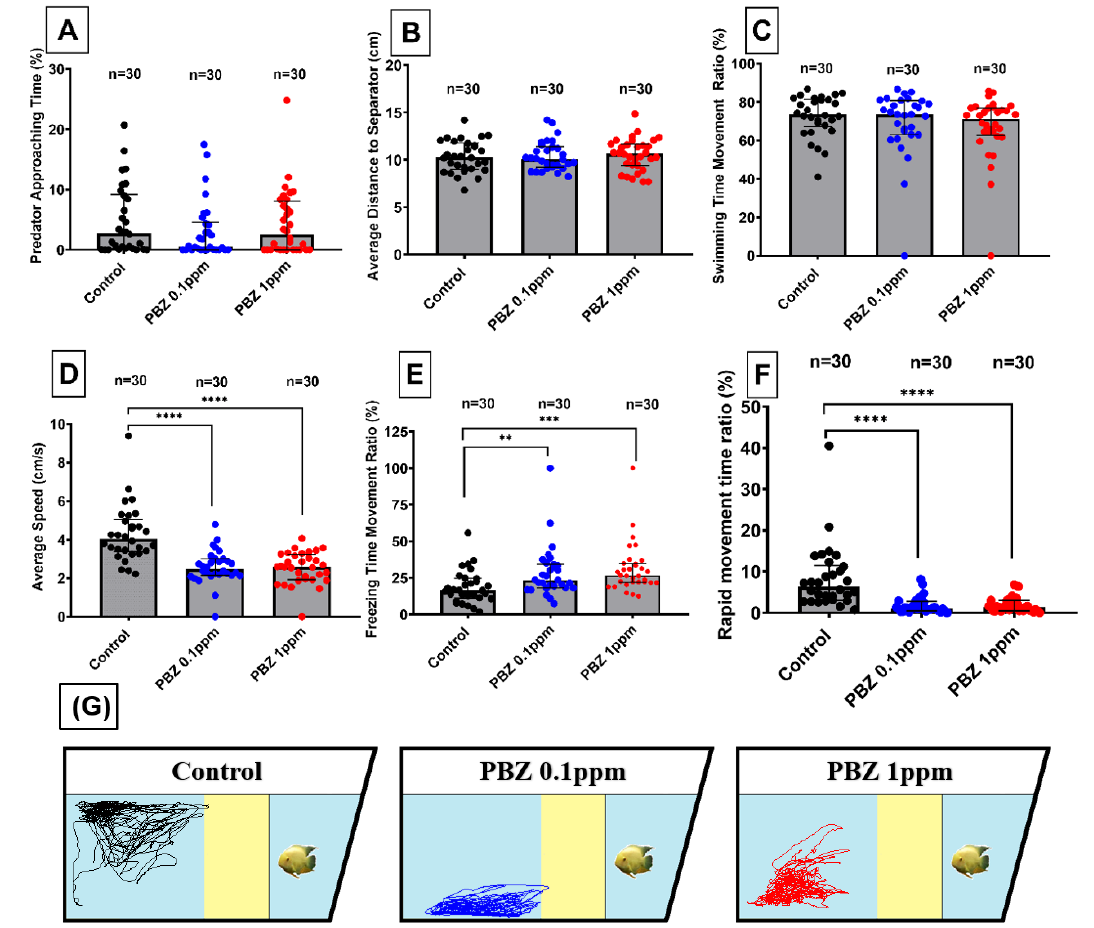
Figure 7. Predator avoidance test for adult zebrafish after exposed to different doses of Paclobutrazol. Six endpoints were measured including: ( A ) predator approaching time, ( B ) average distance to the separator, ( C ) swimming time movement, ( D ) average speed, ( E ) freezing time movement, and ( F ) rapid movement time ratio. ( G ) Trajectories of adult zebrafish in predator avoidance assay after exposed to 0 (control), 100 µg/L (0.1 ppm), and 1000 µg/L (1 ppm) of Paclobutrazol (PBZ). The data are expressed as the means ± S.E.M. and were analyzed by the one-way ANOVA (** p < 0.01, *** p < 0.001, **** p < 0.0001).